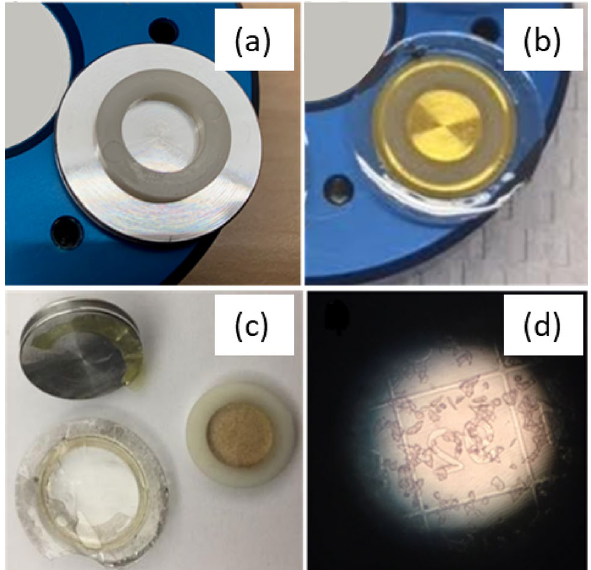
Figure. 11. OSSM sample preparation. A thin ring plastic washer ( a ) is used as a sealing ring to form a container for the embedding medium. The coverslip was placed cell-side down onto the overfilled resin container ( b ). The coverslip was removed after resin polymerization by liquid nitrogen freeze fracture ( c ). Optical micrography of the top surface of the resin block showing imprinted coverslip markings and embedded cells ( d